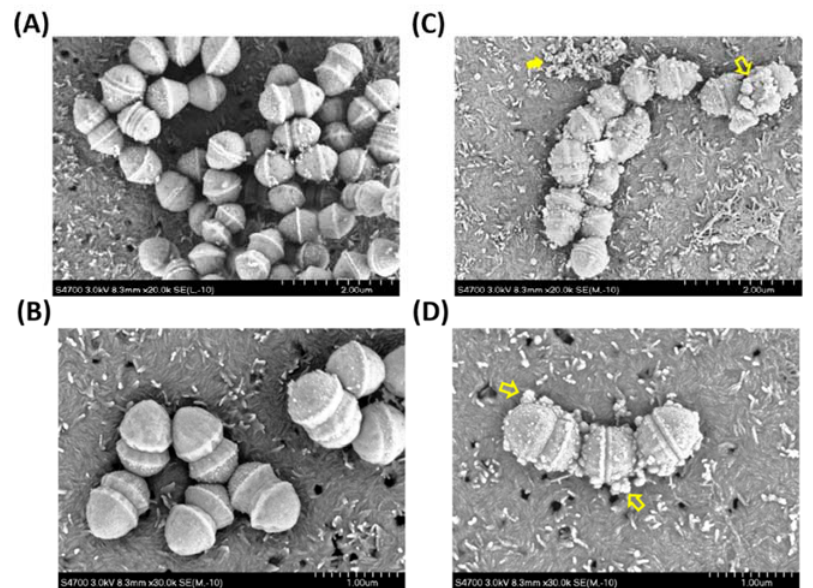
Figure 4. SEM analysis of the AR-12-treated GAS. SEM analysis was performed on NZ131 strain, which was incubated in the absence ( A , B ) or the presence of 2.5 µ g/mL of AR-12 ( C , D ) for 2 h. The untreated GAS showed a smooth cell wall ( A , B ), whereas GAS treated with AR-12 exhibited vesicle-like structures dispersed over the cell wall (hollow arrows, ( C , D )) and displayed a large aggregation of vesicle-like structures (solid arrows, ( C )). Scale bars: 2 µ m ( A , C ); 1 µ m ( B , D